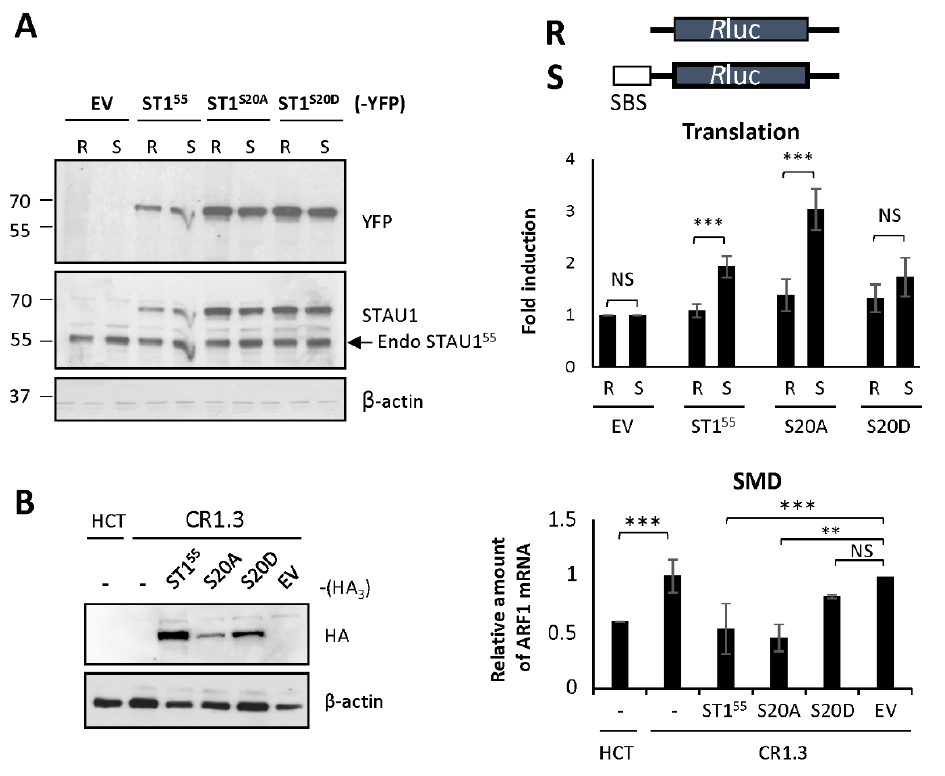
Figure 4. Expression of the phosphomimetic mutant S20D abrogates STAU1 55 -dependent transla- tion and SMD. ( A ) Schematic representation of the reporter proteins used in the translation assay. Rluc, Renilla luciferase; SBS, STAU1-binding site. HEK293T cells were co-transfected with plasmids coding for the reporter Rluc or SBS-Rluc proteins and for STAU1 55 and mutants as indicated. (Left panel) Cell extracts were collected 24 h post-transfection, and the expression of STAU1 55 proteins was analyzed by western blotting. Endo STAU1 55 , endogenous STAU1 55 . (Right panel) Relative translation of Rluc (R) and SBS-Rluc (S) is shown. The graph represents the means and standard deviations of three independently performed experiments. **, p - value ≤ 0.01; ***, p - value ≤ 0.001. NS, not significant. Translation of Rluc in the presence of the empty vector (EV) was arbitrary fixed to 1. ( B ) STAU1-KO HCT116 (CR1.3) cells were transfected with plasmids coding for STAU1 55 , STAU1 55 mutants as indicated, or the empty vector (EV). (Left panel) Expression of the proteins was analyzed by western blotting. (Right panel) RNAs were isolated and ARF mRNA was quantified by RT-qPCR using HPRT and RPL22 mRNAs as normalization controls. The graph represents the means and standard deviations of three independently performed experiments. **, p - value ≤ 0.01; ***, p - value ≤ 0.001. Expression of ARF mRNA in untransfected CR1.3 cells ( -) was arbitrary fixed to 1. Untransfected HCT116 cells (-) were used as a reference for SMD. 2.5. RBD2 Expression is Sufficient to Impair Cell Proliferation and to Induce Apoptosis To determine if RBD2 is sufficient to impair cell proliferation and as corollary if other functional domains of STAU1 55 are synergistically involved in this function, we fused RBD2 to YFP (Figure 5A), a protein that does not impair cell proliferation when expressed in transformed cells. Growth curve assays, initiated 24 h post-transfection, were used to compare the growth of cells expressing RBD2-YFP to that of cells expressing STAU1 55 - YFP, STAU1 Δ88 -YFP, and YFP, as controls (Figure 5B). Western blotting compared the ex- pression of these proteins in HEK293T cells. As expected, the growth of cells expressing STAU1 55 -YFP was lower than those of cells expressing YFP or STAU1 Δ88 -YFP. Interest- ingly, cells expressing RBD2-YFP showed impaired cell proliferation, similar to that of cells expressing STAU1 55 -YFP. To determine if RBD2-YFP is able to induce apoptosis, cells were then transfected with plasmids coding for RBD2-YFP, STAU1 55 -YFP, or STAU1 Δ88 -YFP and immediately